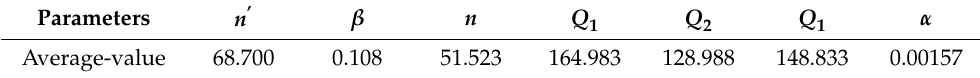
Figure 7. Relationships among different parameters: ( a ) 𝑙𝑛𝜎 ‐ 𝑙𝑛𝜀(cid:4662) ; ( b ) 𝑙𝑛𝜎 ‐ 1/T; ( c ) 𝜎 ‐ 𝑙𝑛𝜀(cid:4662) ; ( d ) 𝜎 ‐ 1/T; ( e ) 𝑙𝑛𝑠𝑖𝑛ℎ(cid:4666)𝛼𝜎(cid:4667) ‐ 𝑙𝑛𝜀(cid:4662) ; ( f ) 𝑙𝑛𝑠𝑖𝑛ℎ(cid:4666)𝛼𝜎(cid:4667) ‐ 1/T. Table 4. Detailed fitted parameters of AP model under different strain rates at RT and 630 °C. Parameters